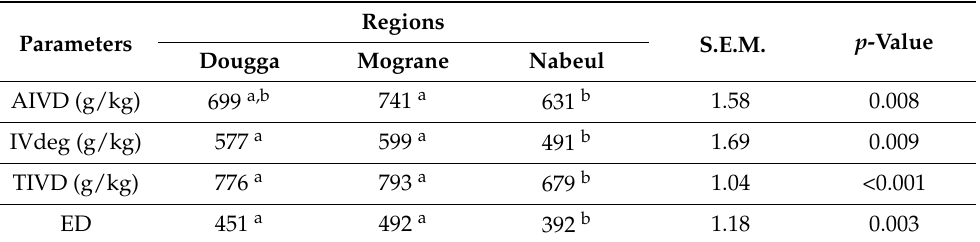
Table 2. In vitro dry matter degradability of Ajuga. iva leaves cultivated from three different regions in Tunisia.